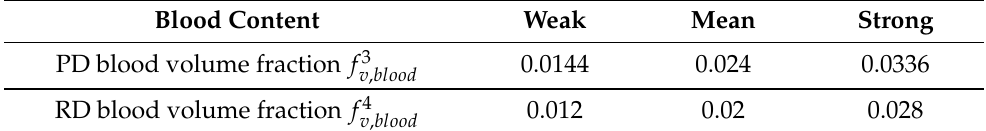
Table 4. Values of the volume fraction of blood in the papillary dermis (PD) and reticular dermis (RD) used for simulating a dermis with more or less blood content.